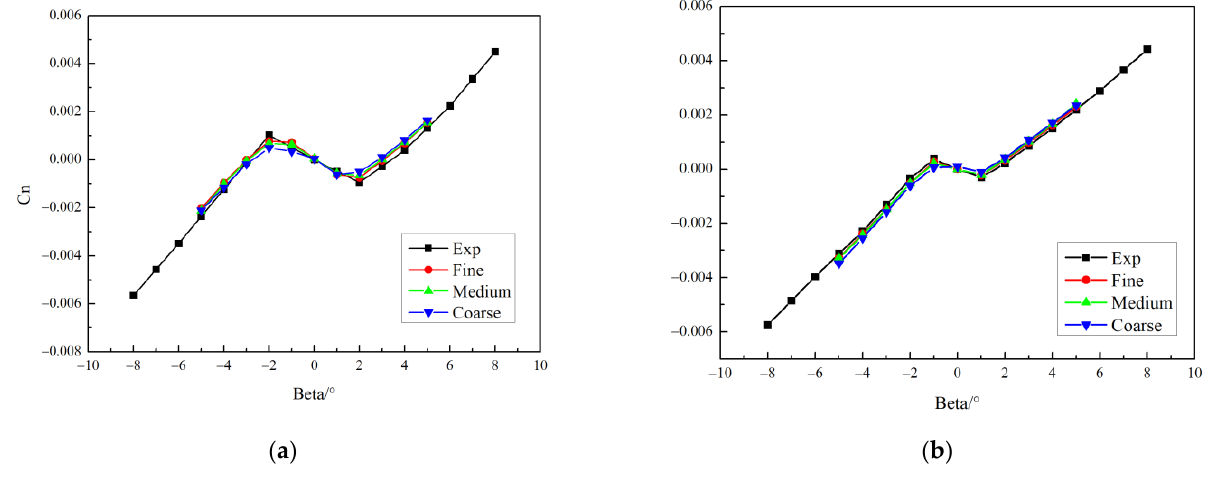
Figure 10. Coefficient of yaw moment calculated with three different grids, and comparison with the experimental results. ( a ) α = 0 ° ( b ) = −4 °.